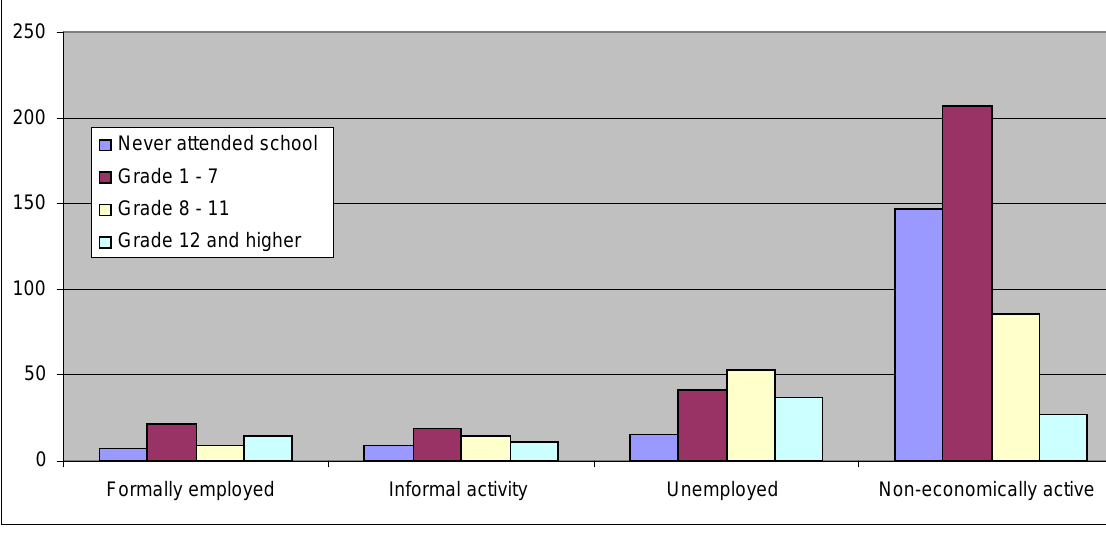
Figure 1: Cross-tabulation of employment status and qualifications of the population in